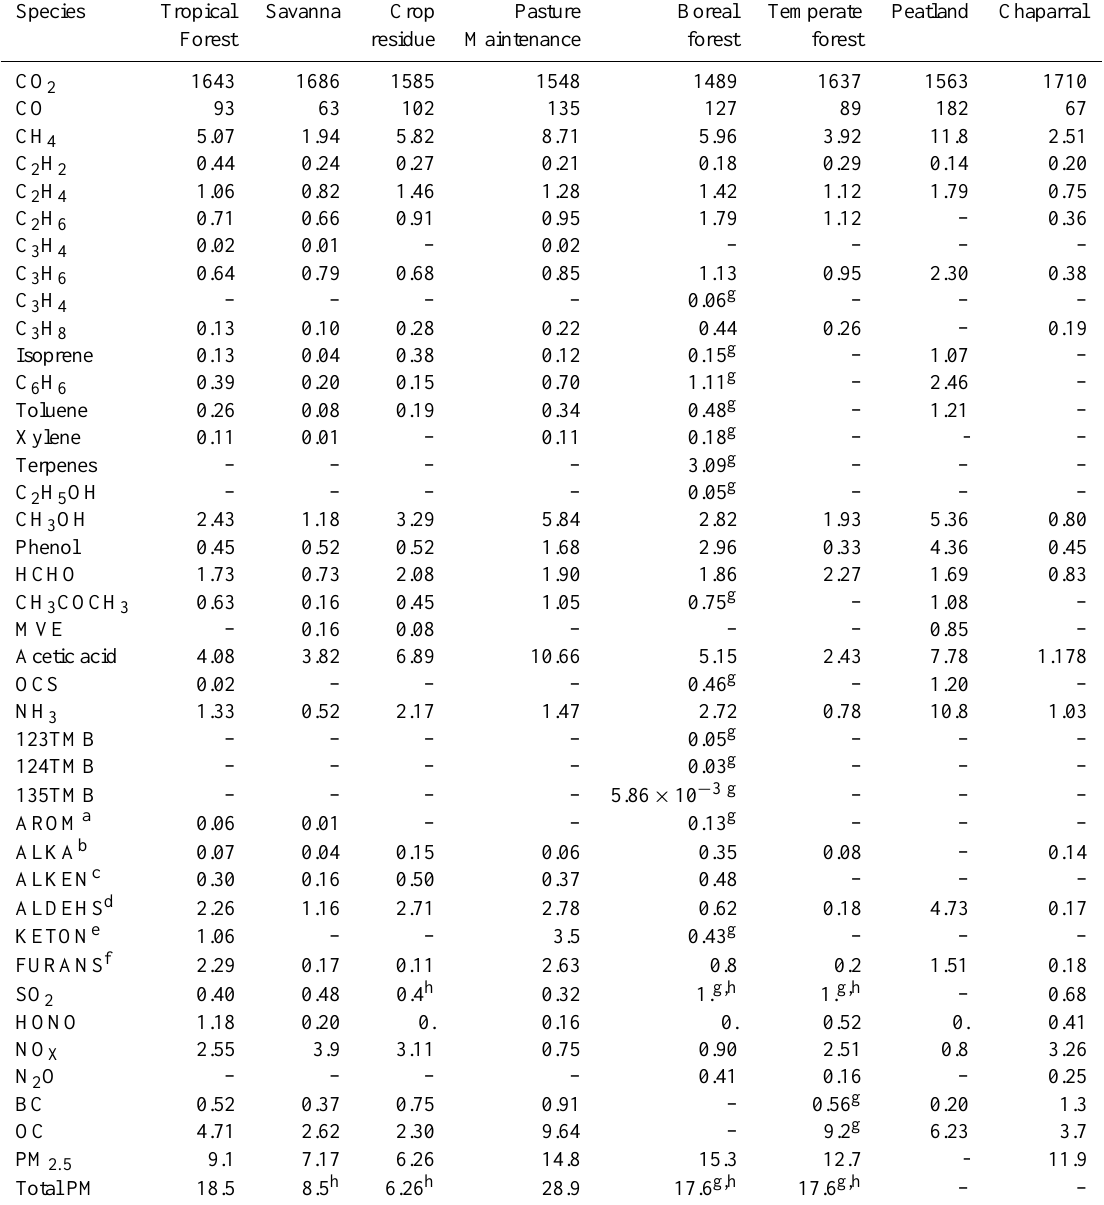
Table 5. Emission factors (in gkg − 1 DM) used for the species included in the inventory. All numbers are from the review by Akagi et al. (2011), except noted otherwise. Species Tropical Savanna Crop Pasture Boreal Temperate Peatland Chaparral Forest residue forest forest